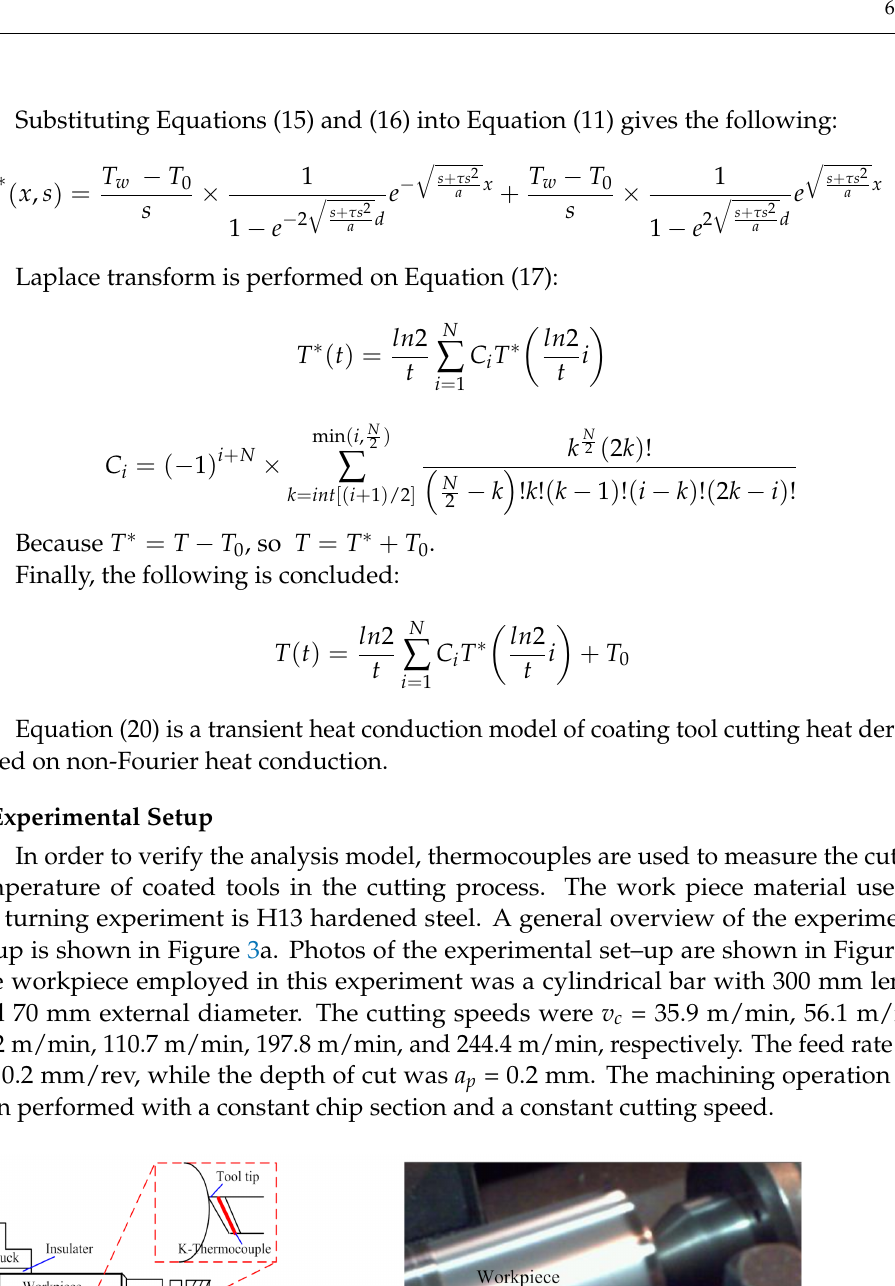
coated sample was given to the thickness measurements shown in Figure